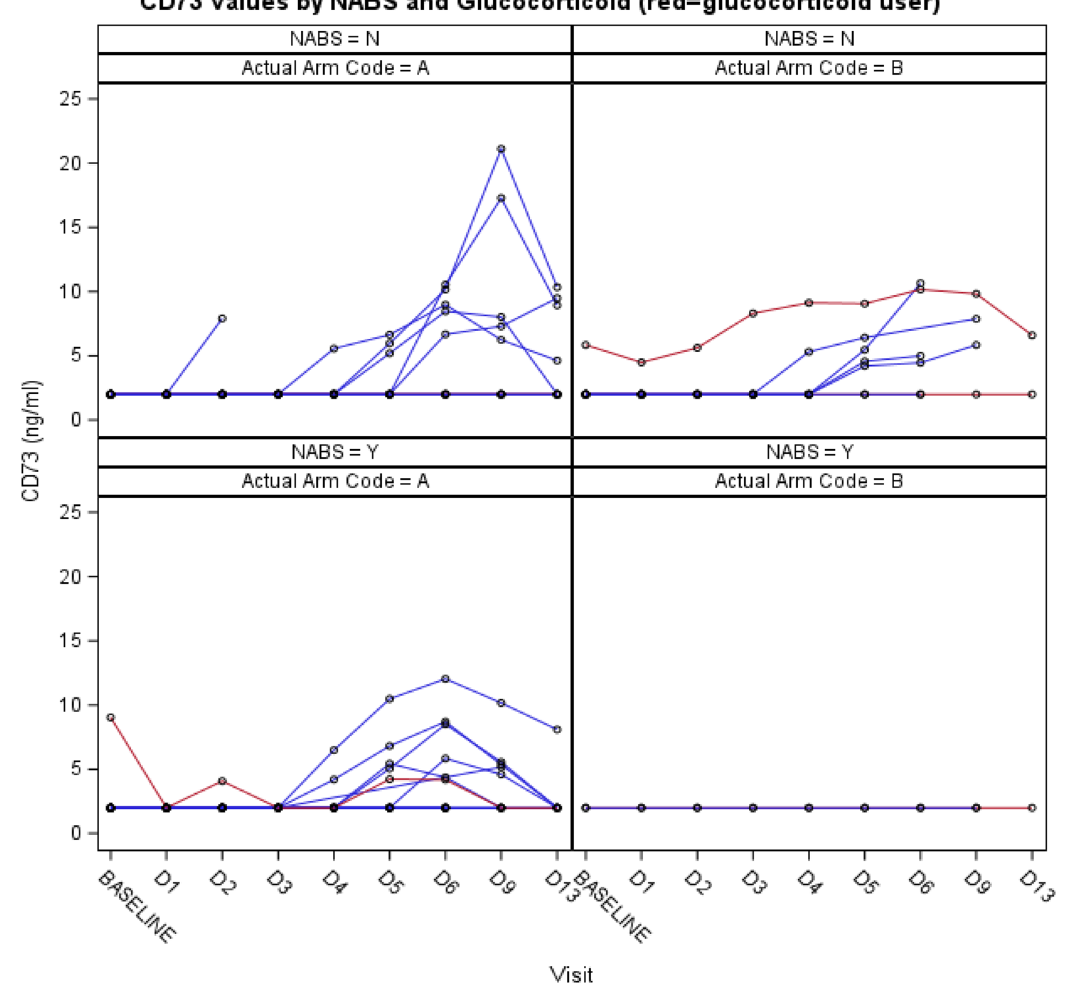
Figure 4. Cluster of differentiation (CD73) values in both treatment groups (A = IFN beta-1a group; B = placebo group) according to the presence of IFN beta-1a neutralizing antibodies (NABS) (Y = yes, elevated levels; N = elevated levels not detected).